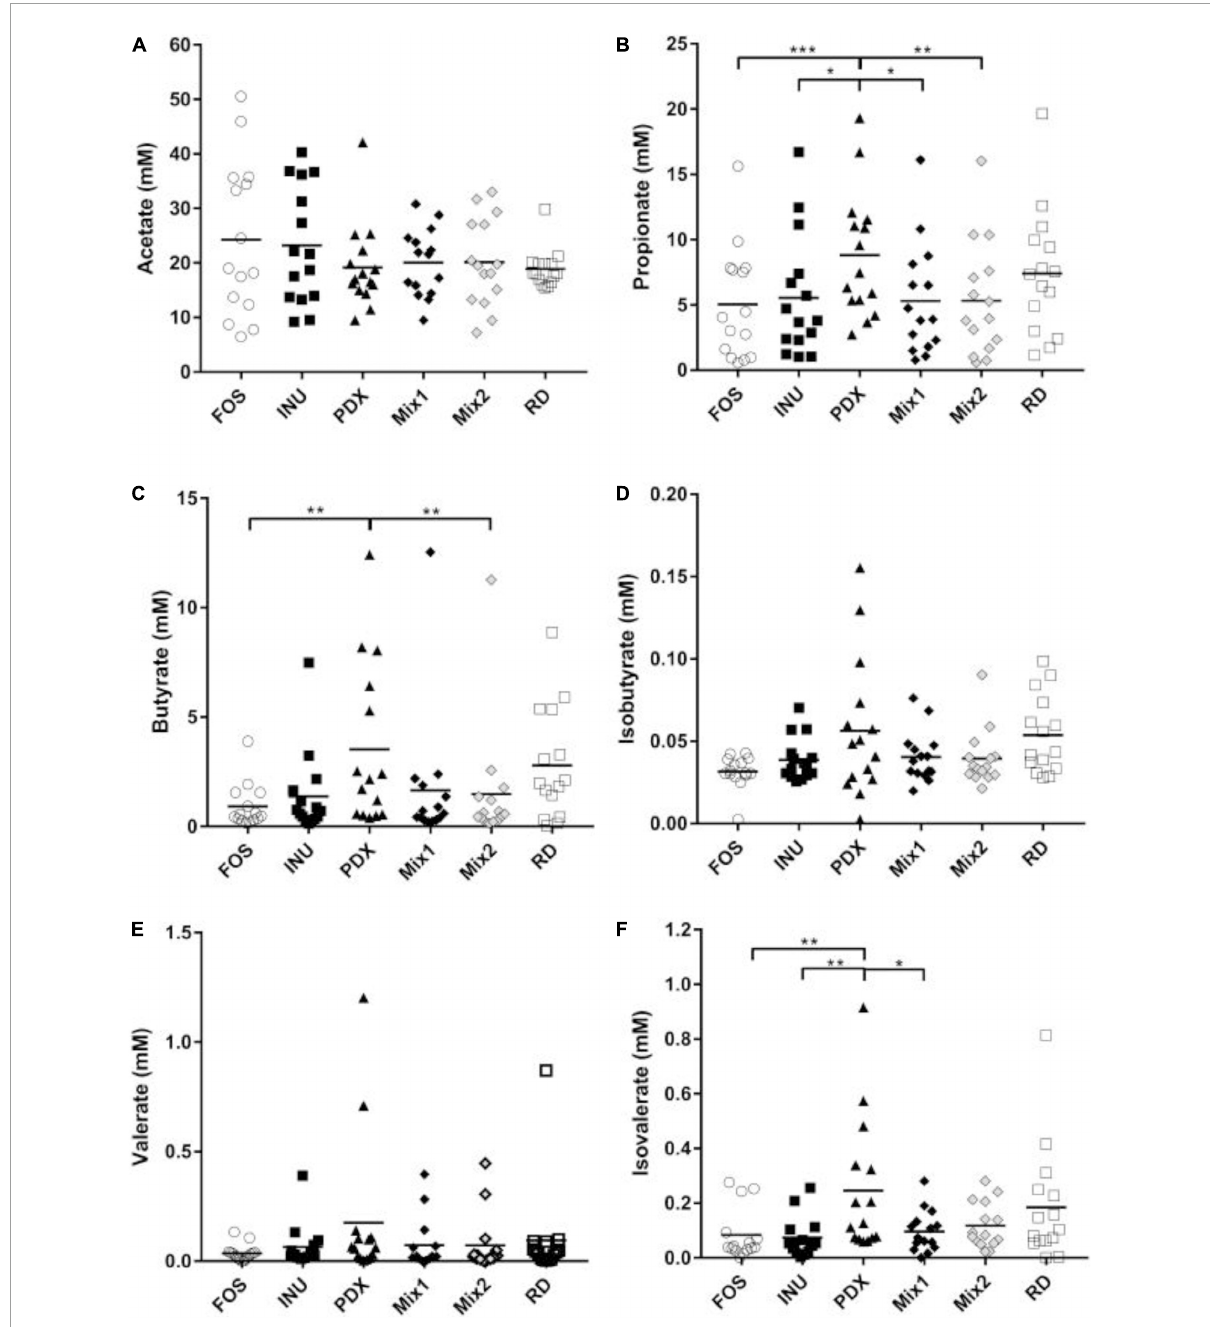
FIGURE2 Comparison of individual SCFAs after 24h in vitro fermentation. The concentrations of individual SCFAs, including acetate (A) , propionate (B) , butyrate (C) , isobutyrate (D) , valerate (E) , and isovalerate (F) were determined by GC with the internal standard method. The data of fifteen volunteers were shown in a scatter dot plot, line is at mean. Only the significant differences between inulin (INU) and PDX were shown. * p value < 0.05, ** p value < 0.01, *** p value <